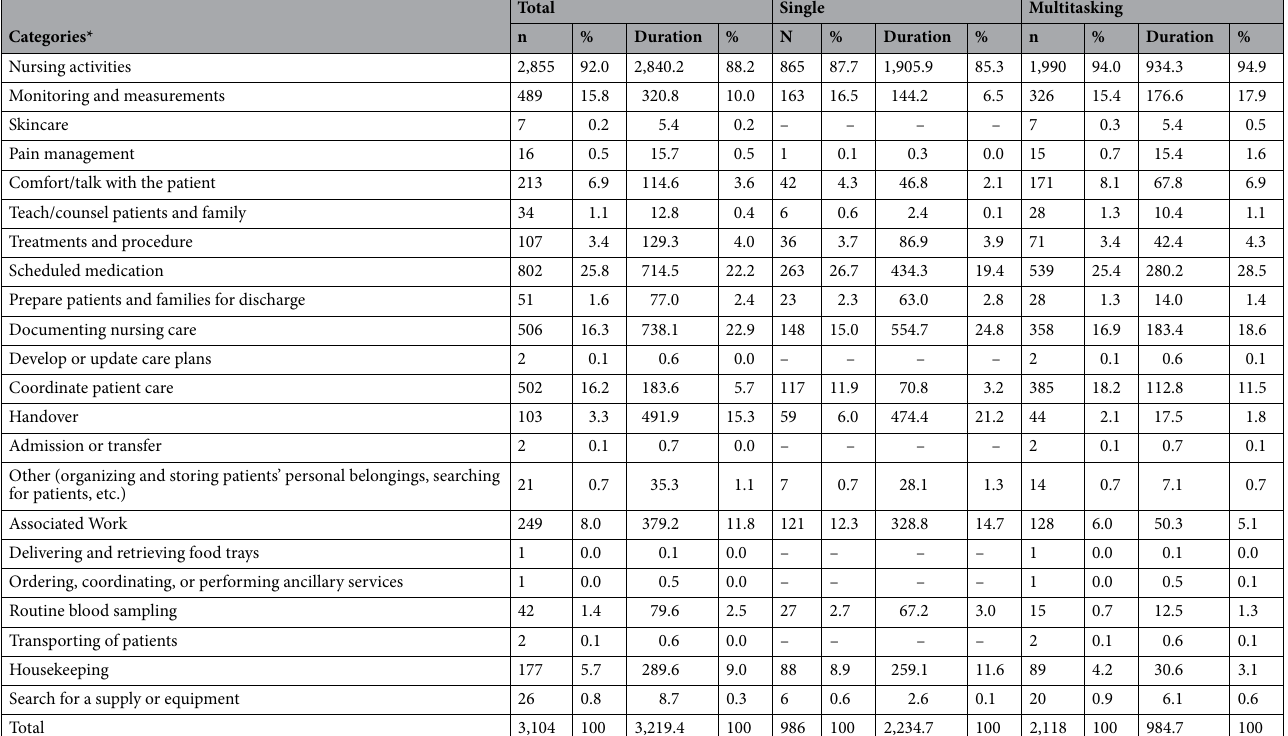
Table 3. Analysis of the frequency and time spent on nursing activities (single task and multitasking). Note: The frequency of multitasking nursing activities was calculated as separate nursing activity. Multitasking nursing activity implies two or more nursing activities of 5 seconds or more. Duration is expressed in minutes. –, = not reported